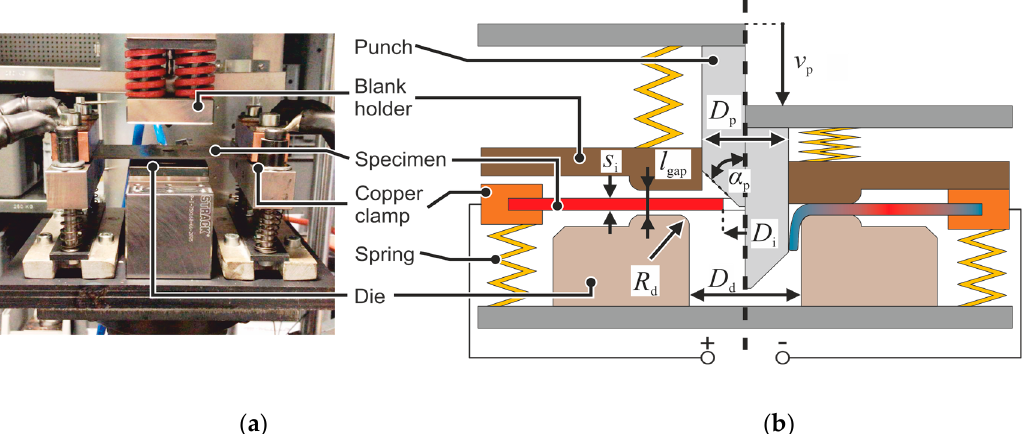
Figure 3. ( a ) Implementation of hot hole-flanging in a Zwick Z250 universal testing machine; ( b ) Schematic setup of hot